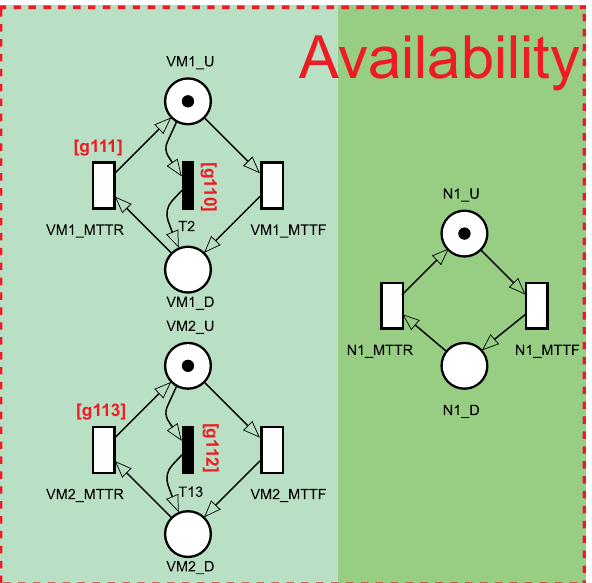
Figure 7. Availability sub-module encompassing availability aspects related to the fog node and respective virtual